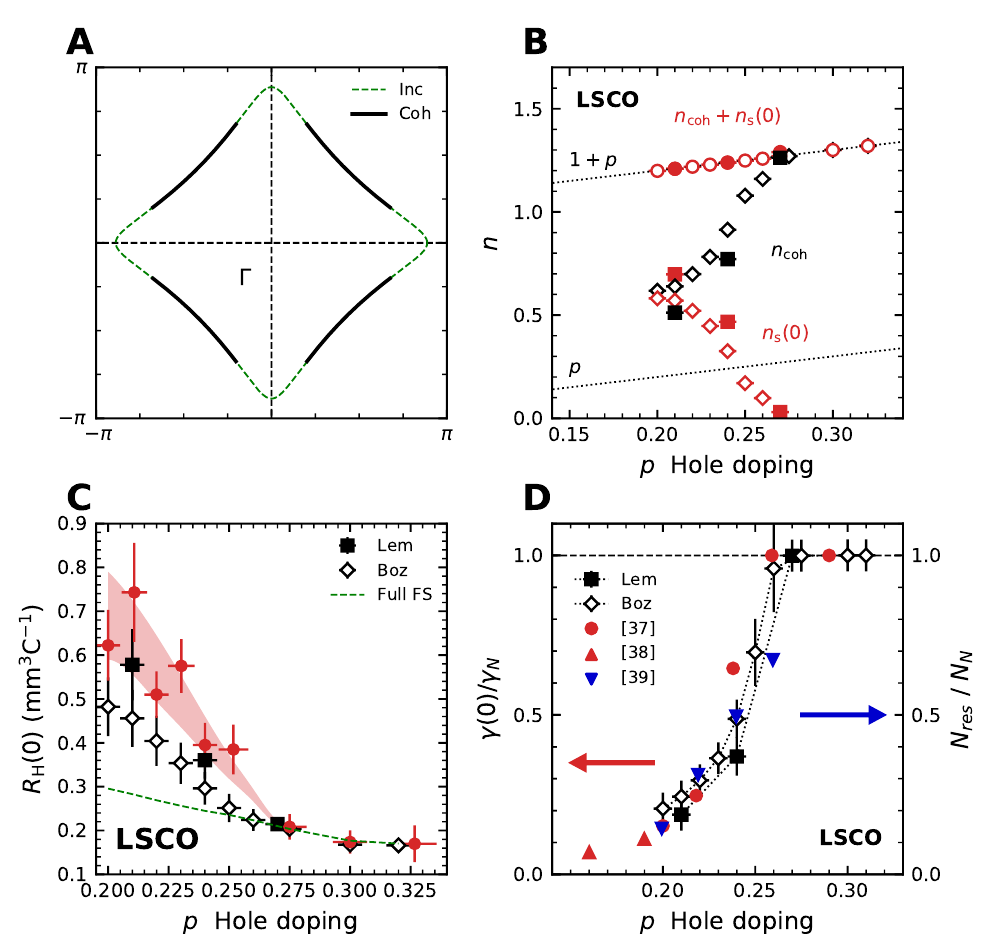
Figure 2: Possible break-up of the Fermi surface in OD LSCO into coherent and incoherent sections and its possible consequences. A) Example of a truncated FS (corresponding to p = x = 0.23) in which anti-nodal sections (green dashed lines) exhibit incoherent charge dynamics and the nodal sections (bold black lines) are co- herent. Note that a similar delineation of the FS is seen in ARPES [ 44 ] . B) n (0) s ( 0 ) in at selected dopings extracted from mutual inductance measurements of 1 /λ 2 ab LSCO thin films by Božovi´c et al. (open red diamonds) [ 7 ] and Lemberger et al. (filled red squares) [ 45 ] . Black empty diamonds (filled squares) represent n , the density coh of coherent carriers at low- T deduced from each corresponding data set, assuming = (1 + p ) - n ( 0 ) in OD LSCO. (Red circles) n (0). C) Doping dependence of R coh s H ( 0 ) (see Table 8). Red shaded area in- Binned and averaged literature values for R H dicates the spread in the (binned and averaged) experimental values. Green dashed ( 0 ) calculated using Boltzmann transport line represents the doping dependence of R H theory and assuming the entire FS is coherent. Note the clear bifurcation between ( 0 ) at p = 0.27. Open diamonds experimental and Boltzmann-derived values of R SC H ( 0 ) obtained by truncating the FS integral (filled squares) represent the calculated R H for σ as constrained by the n values shown in panel B and deduced from the x y coh Božovi´c [ 7 ] (Lemberger [ 45 ] ) n (0) values. D) Residual density of states within the s superconducting state of OD LSCO as determined by specific heat (circles [ 46 ] and tri- angles [ 47 ] ) and Knight shift (inverted triangles) [ 48 ] studies. Again, open diamonds (filled squares) are the residual density of states calculated using the same truncated FS integrals employed in panel C and the n (0) values deduced from Ref. [ 7 ] ( [ 45 ] ), s respectively. The error analysis for all panels is described in appendix